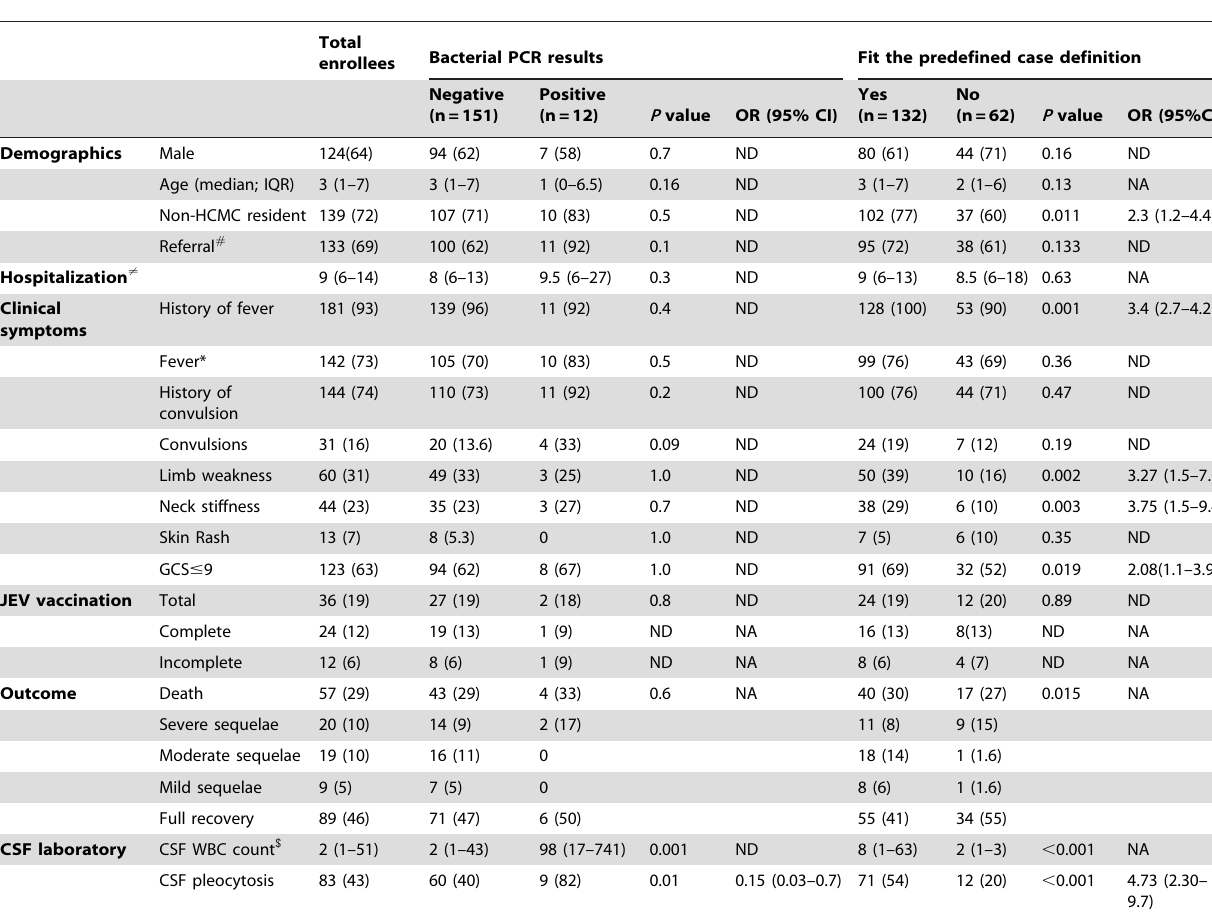
Table 3. Characteristics of enrollees and comparisons between patient